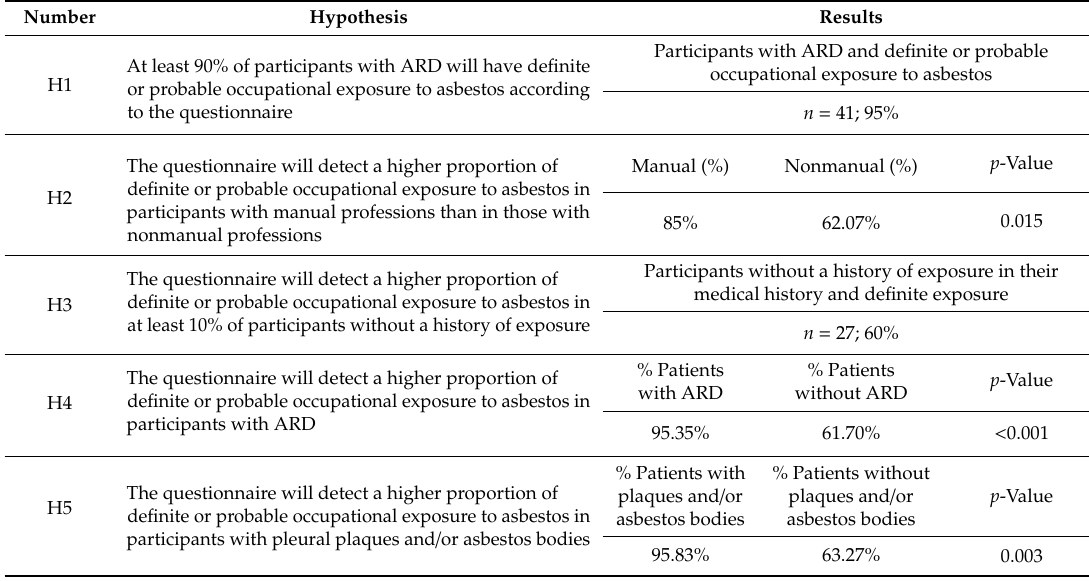
Table 3. Tests of the hypotheses for assessing construct